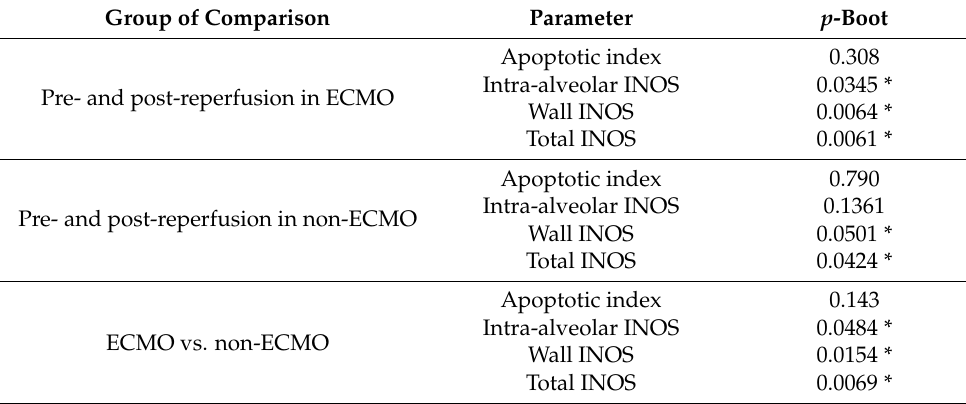
Table 4. Comparison of the variability in the interquartile ranges of apoptotic indexes and INOS values. A p -value < 0.05 indicates a statistically significant difference in variability (measured as an interquartile range).